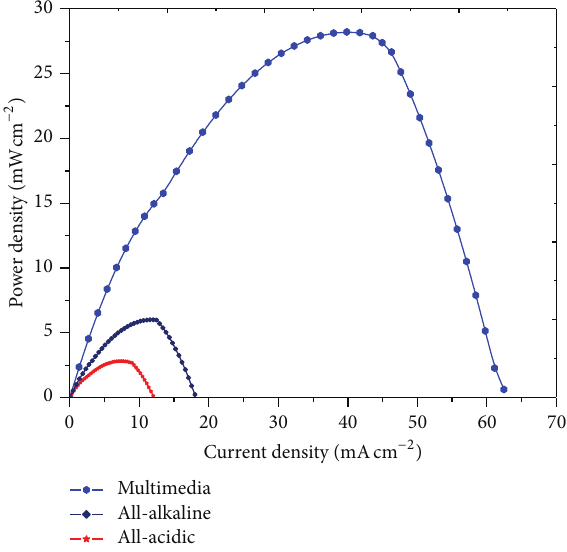
Figure 3: Polarisation curves of MLSPBFC with an alkaline anode and acidic cathode (acid-alkaline media) at room temperature. For comparison, also the polarisation curves of the MLSPBFC run in all- alkaline and in all-acidic media are included. [Fuel]: 2M formic acid + 0.5 M NaOH. [Oxidant]: 0.1M perborate + 0.5 M H 2 SO 4 . Stream flow rates: 0.3 mLmin −1 .